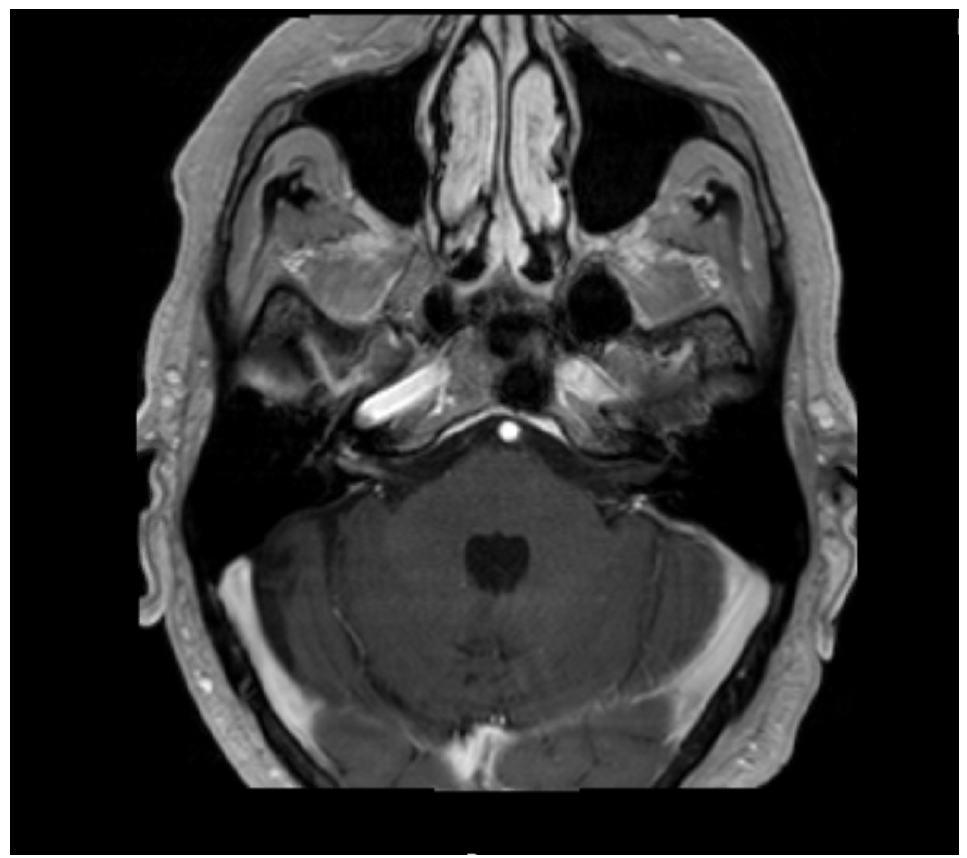
Figure 1. The MRI of brain showed linear enhancement of the 7th and 8th cranial nerves (CN) within the internal auditory canal, which is indicative of inflammation of the two cranial nerves.